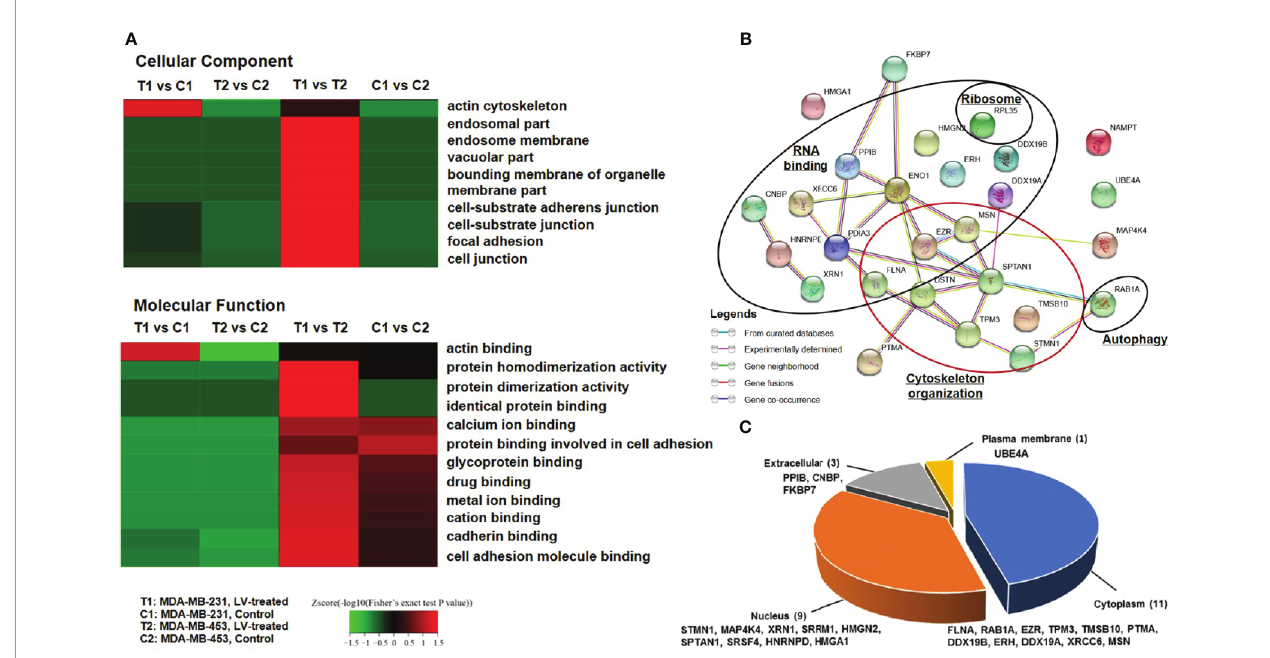
FIGURE 1 | Lovastatin induces lysine succinylation (Ksucc) of cytoskeleton-associated proteins. Gene Ontology (GO) analysis showing the enrichment of Ksucc- modi fi ed proteins involved in cytoskeleton organization in MDA-MB-231 CSCs treated with lovastatin (1 m M, 48 h) (A) . Protein-protein interaction network generated using the STRING database (https://string-db.org/) showing the functional groups of lovastatin-dysregulated Ksucc-modi fi ed proteins in MDA-MB-231 CSCs (B) . Pie-chart showing the distribution of Ksucc-modi fi ed proteins in different cellular components of MDA-MB-231 CSCs (C) . LV,